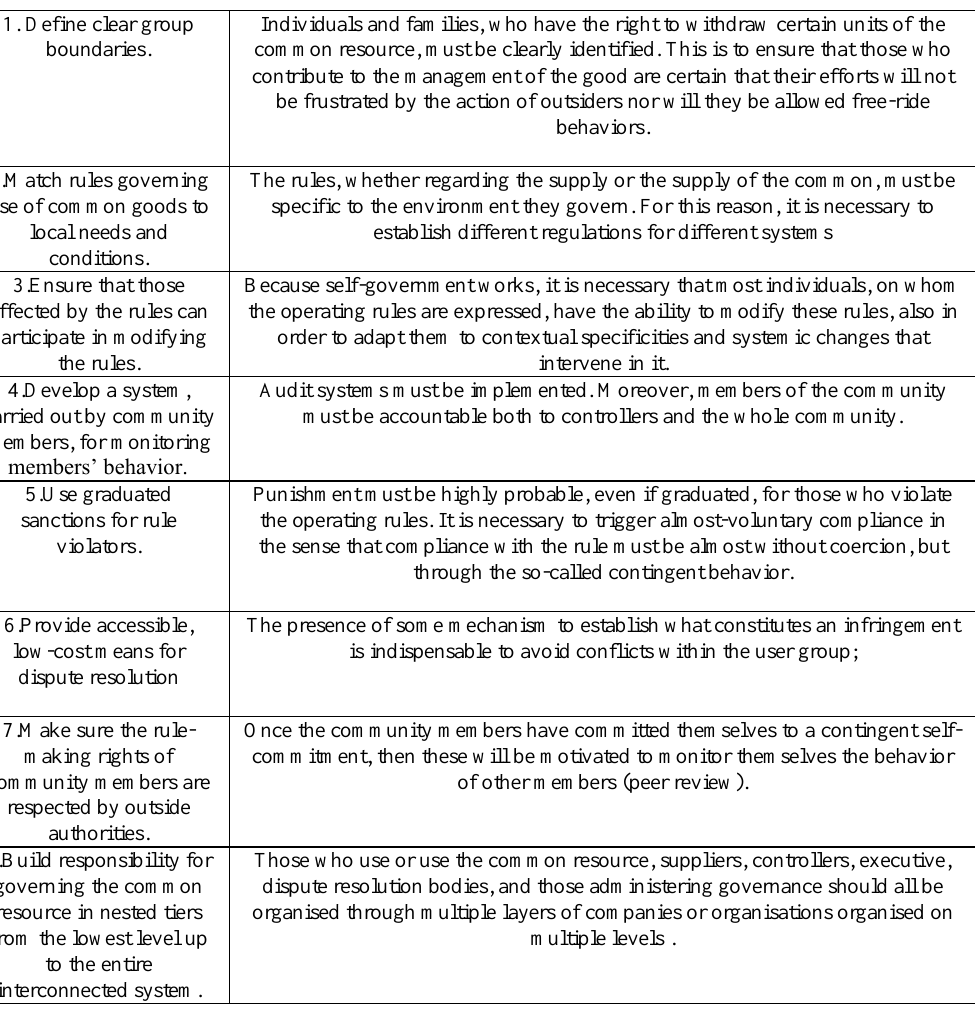
Table 1: Organisational Principles of Ostrom's